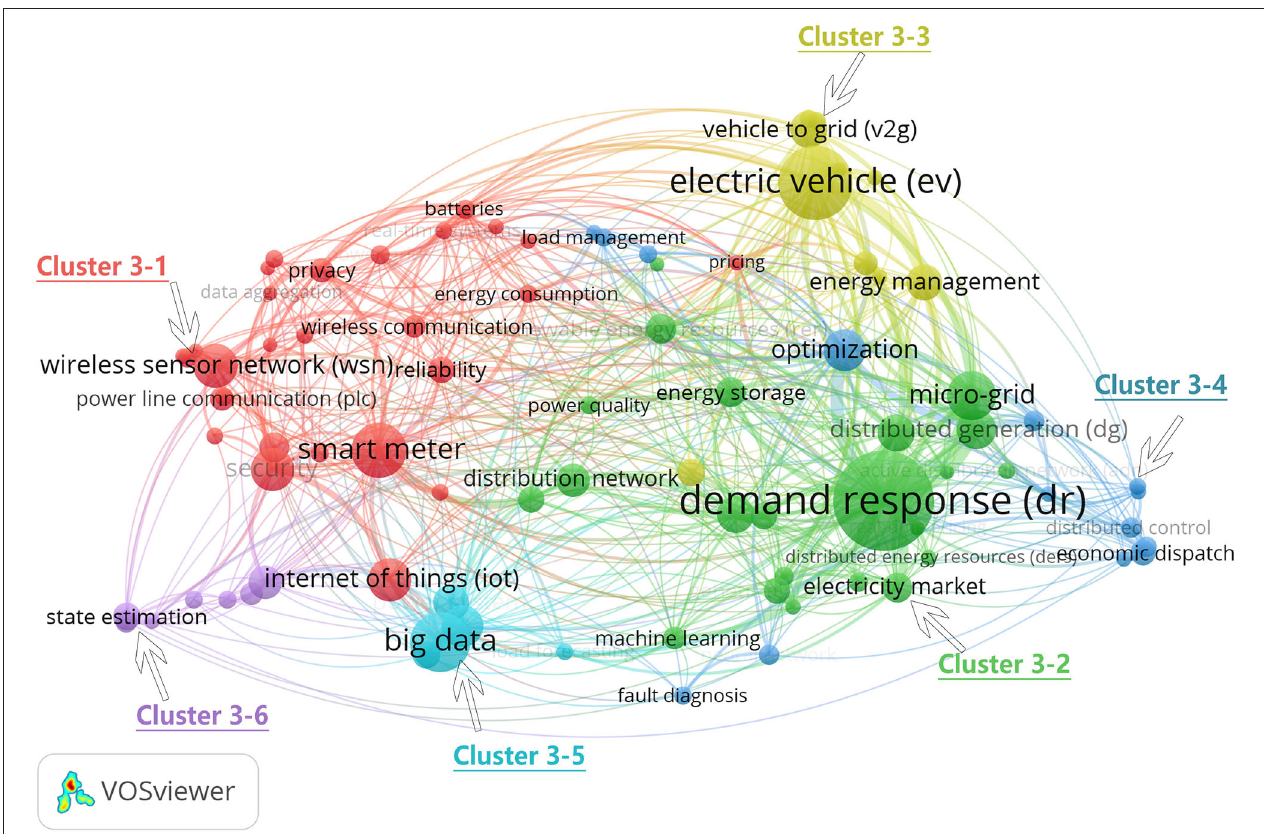
smartgrid, smart grid, and smart grids are not